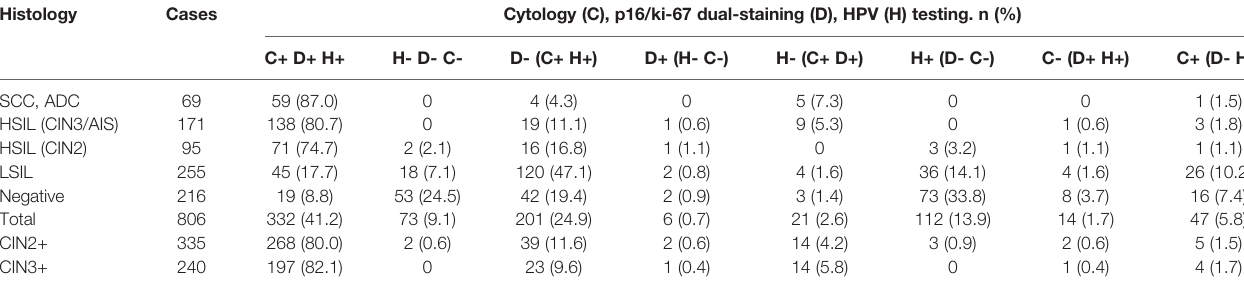
TABLE 5 | Triple detection with p16/ki-67 dual-staining, cytology, and HPV testing. Histology